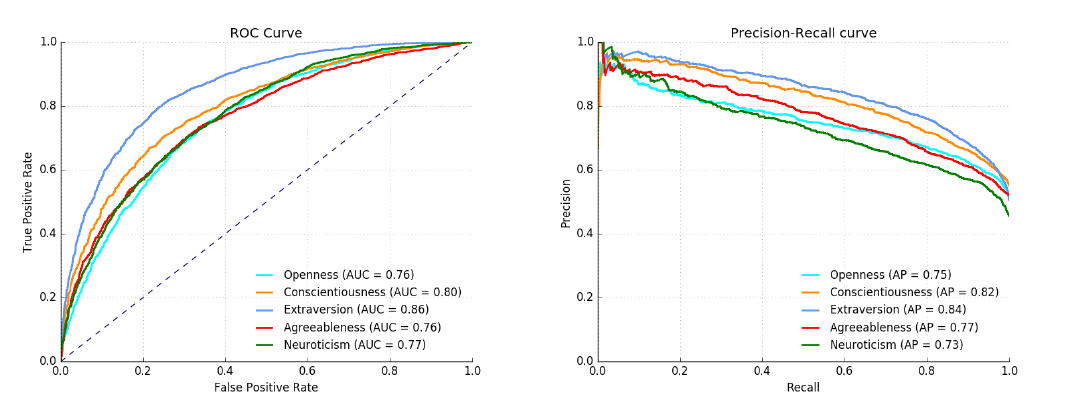
Figure 2. Receiver operating characteristic and Precision-recall curves for all the personality traits. The ROC plot also shows the Area under the curve for each trait, and the PR plot shows the Average precision for each